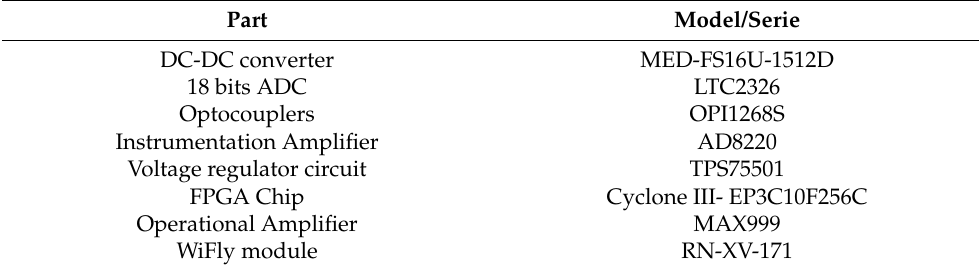
Table 1. Main components of the current monitor prototype.